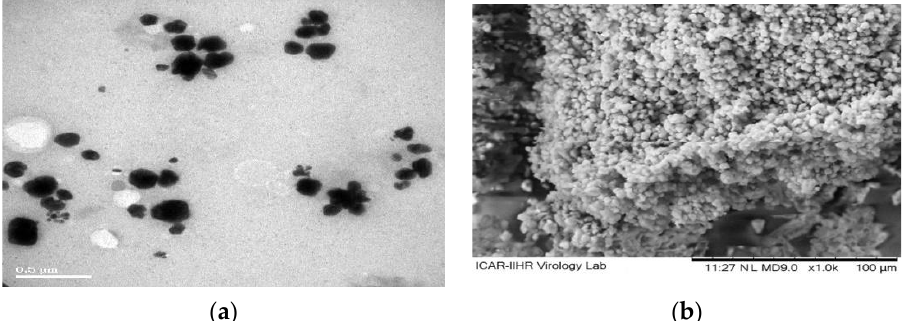
Figure 1. Transmission ( a ) and scanning electron microscopy ( b ) representative images of chitosan- encapsulated meloxicam nanoparticles.